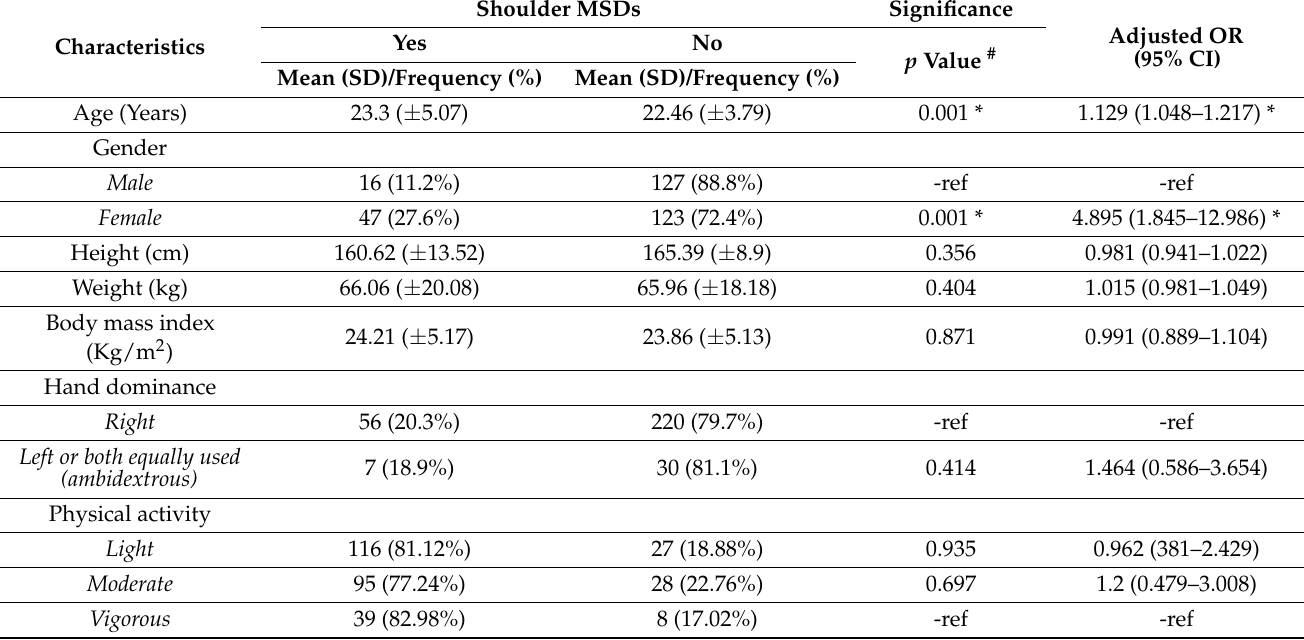
Table 3. Association between shoulder MSDs and participant characteristics.